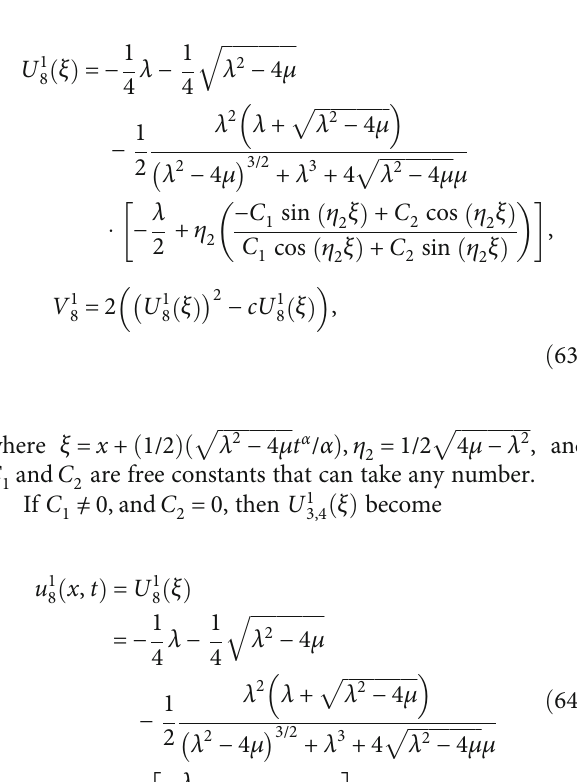
ffiffiffiffiffiffiffiffiffiffiffiffiffiffiffi p λ 2 − 4 μ